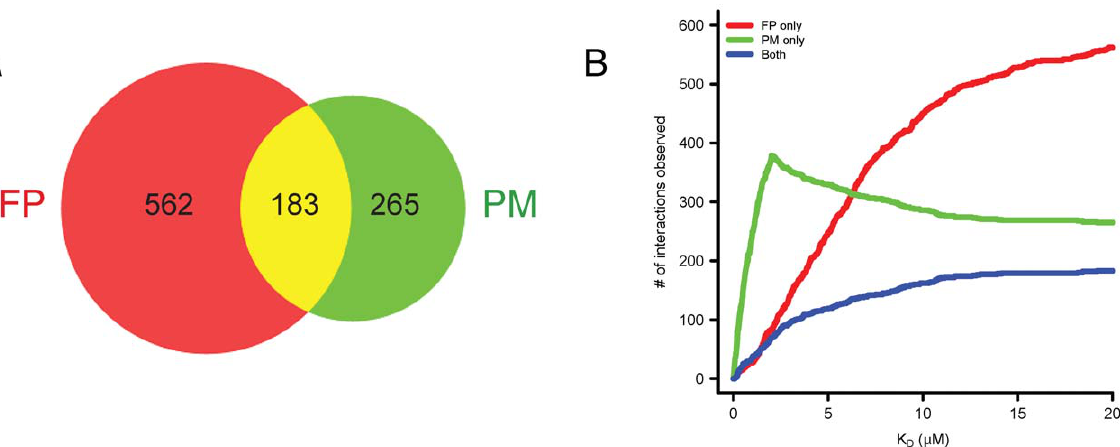
Figure 4. Methodological cross-comparison of SH2 interactions determined by fluorescence polarization or in published protein microarray data for the ErbB family. ( A ) Venn diagram comparison of overall SH2 recruitment profiles revealed by FP and PMs for the ErbB family of RTKs for only peptides and proteins tested by both platforms. The red circle represents protein-peptide interactions observed by FP; the green circle represents protein-peptide interactions previously observed by PMs; and the yellow overlap represents interactions observed by both methods. ( B ) SH2 and ErbB interactions quantified over a range of binding affinity thresholds as determined previously by PMs and in this study by FP data. The red line represents interactions characterized exclusively by FP; the green line represents interactions characterized exclusively by PMs; the blue line represents interactions observed by both methods.